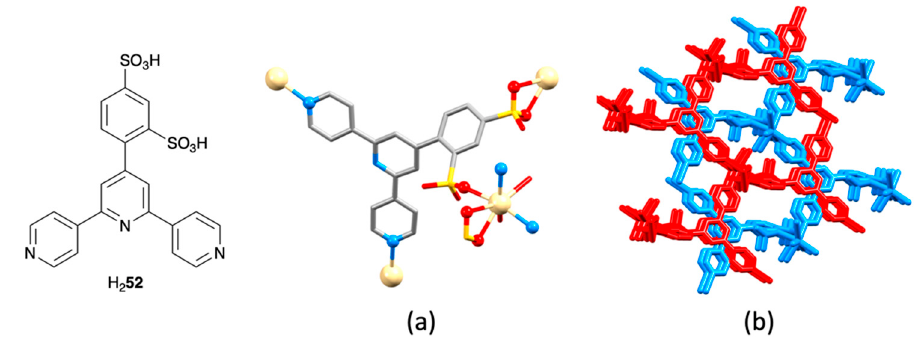
Figure 35. The structure of H 2 52 . In [Cd( 52 )(OH 2 ) 2 ] n , ( a ) both 52 2– and Cd(II) are 4-connecting nodes, and ( b ) the coordination assembly comprises 2-fold, interpenetrating 3D networks (CSD refcodes QJARAU and QJARAU01).